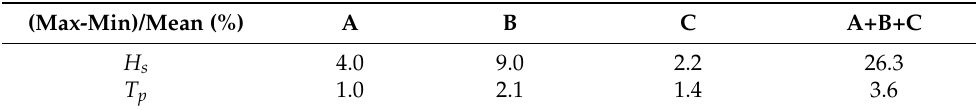
Table 6. Variations in H s and T p for different random seed